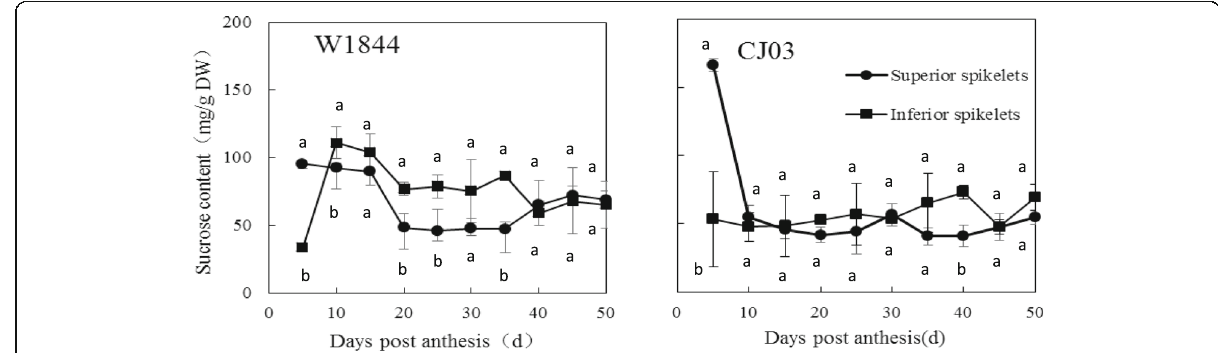
Fig. 7 Changes of sucrose content in spikelets during grain filling stage in W1844 and CJ03. Values are means ± SE ( n = 10). Different letters indicate statistically significant differences at the P = 0.05 level by Duncan ’ s